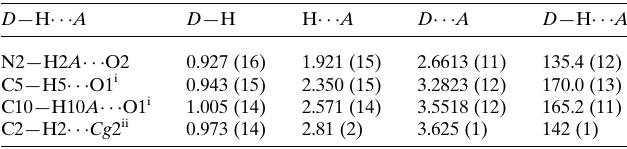
Table 1 Hydrogen-bond geometry (A˚ , (cid:3) ). Cg 2 is the centroid of the C11–C16 benzene ring. D —H (cid:2)(cid:2)(cid:2) A